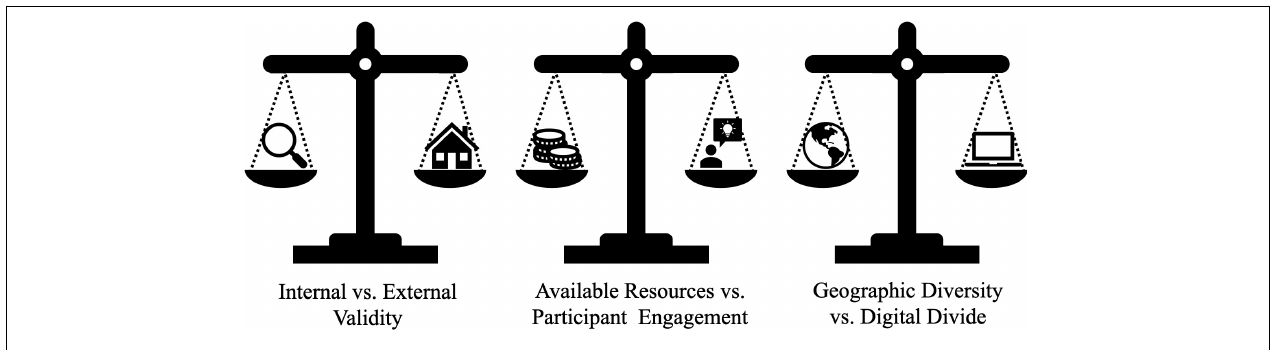
FIGURE 5 | Tradeoffs for online intervention studies with developmental populations.